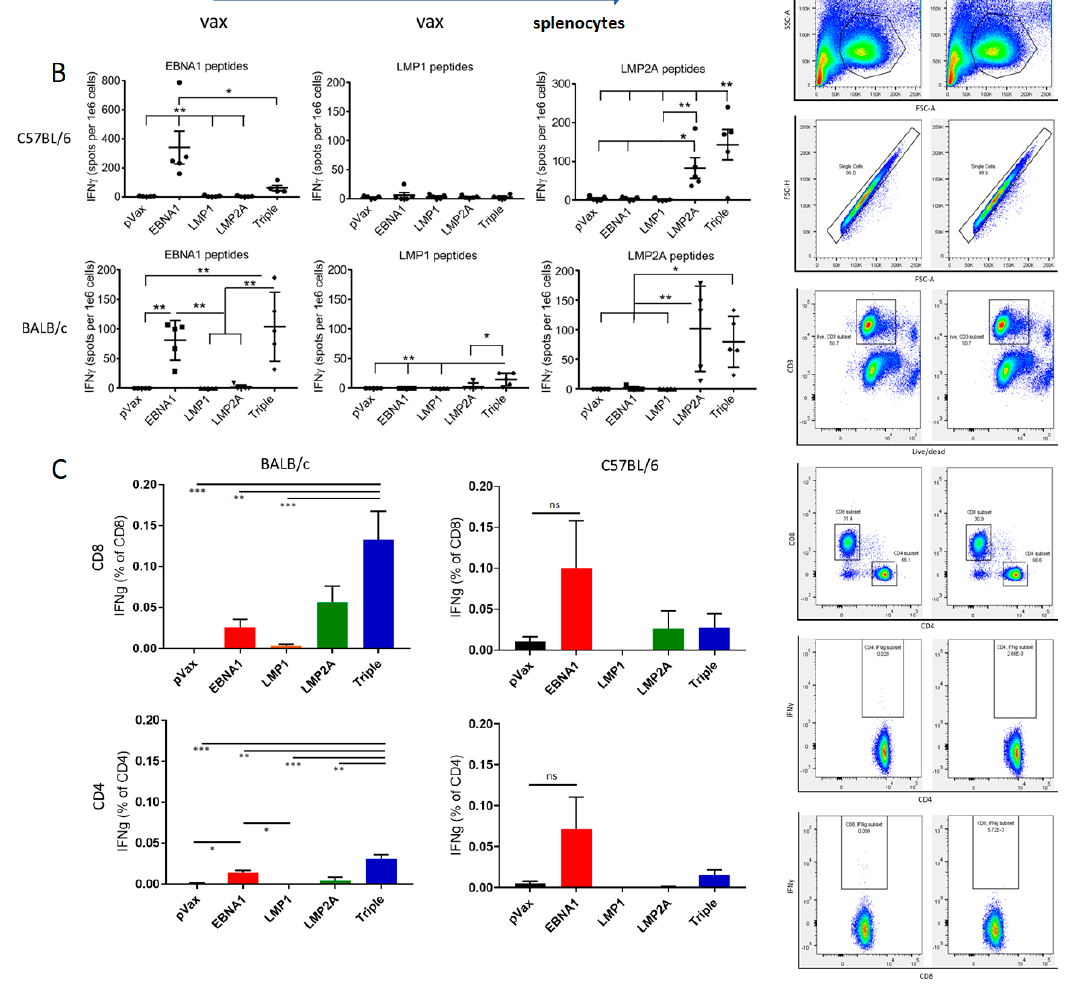
Figure 2. DNA vaccination produces strong cellular responses in inbred mice. ( A ) Vaccination schedule to test the immunogenicity of latent proteins in inbred mice. 2 doses of individual or combined latent protein vaccines (vax) were given to groups of 5 BALB/c or C57BL/6 mice two weeks apart, with mouse splenocytes being harvested one week after the final dose (sac). ( B ) Cellular responses of BALB/c and C57BL/6 mice measured using IFN γ ELISPOT after overnight stimulation